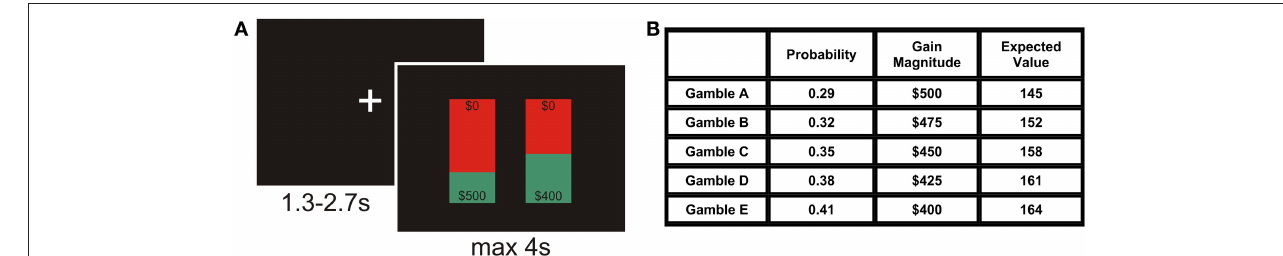
Participants had 4 s to indicate which of the two gambles they would prefer to play. After making a decision, the selected gamble was enlarged for 500 ms. (B) Gambles used in the experiment. There were five different gambles that were presented in all ten possible pairwise combinations in a randomized fashion. The winning probability increased from gamble A to E in steps of 0.03, and the gain magnitude decreased from A to E in steps of $25, so that gambles with higher magnitudes had lower probabilities and vice versa. We used the minimum step-size of changes in probability (0.03) and gain magnitude ($25) to measure the gamble-distance in every presented gamble pair (see text for ). safer